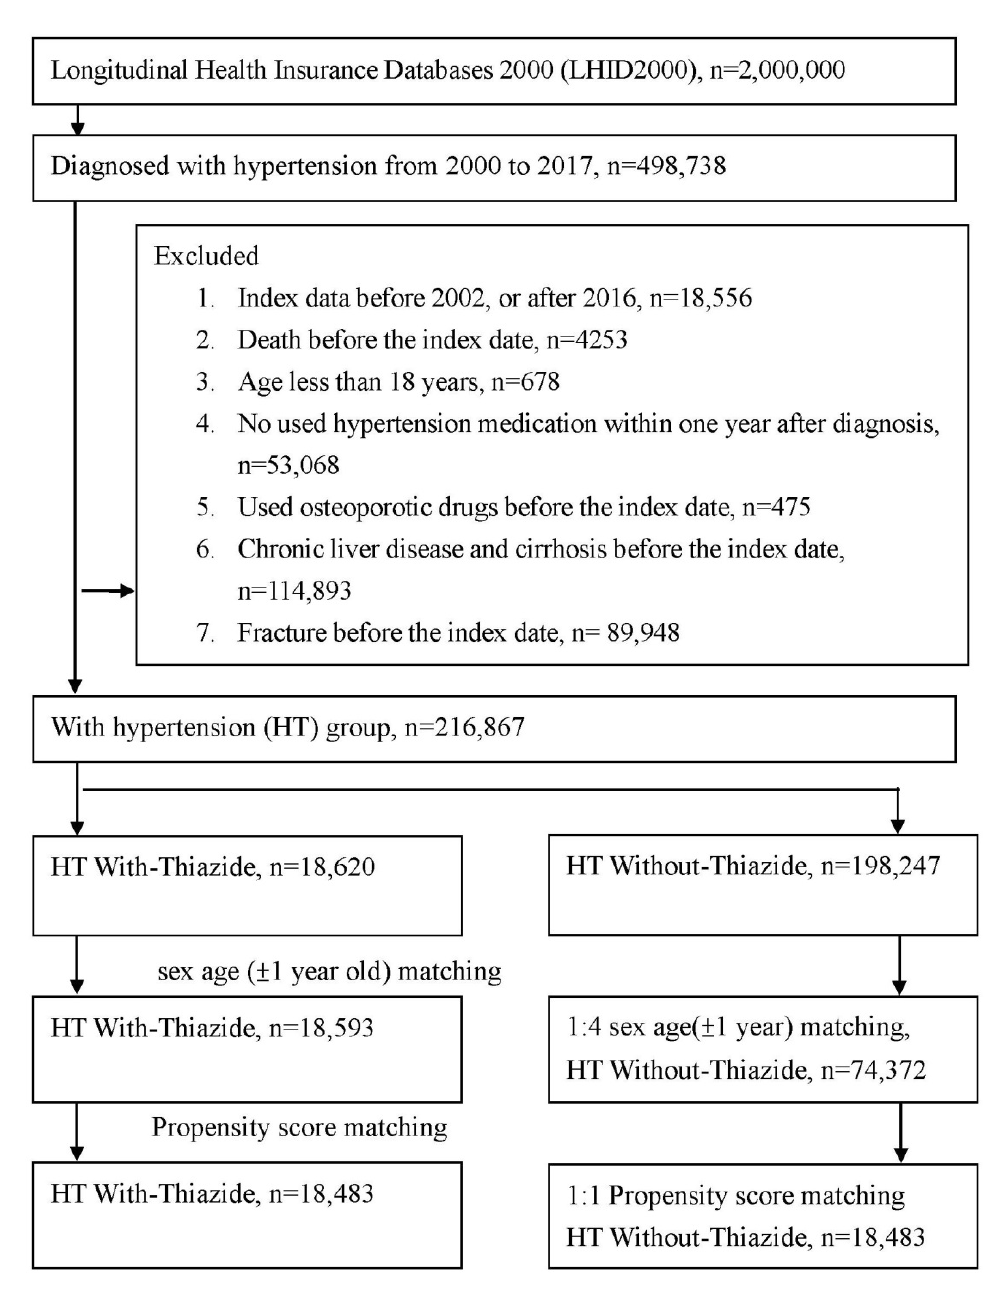
Figure 1. Study flowchart of patient selection.